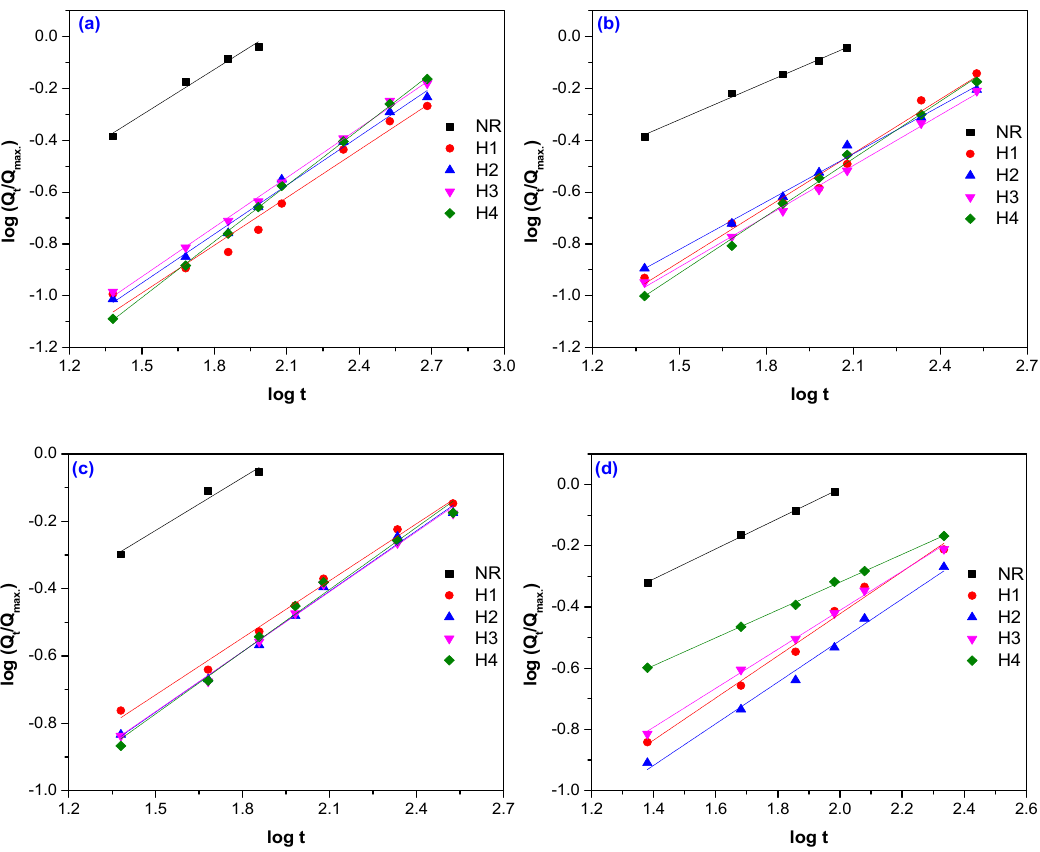
Figure 5. Determination of the diffusion parameters n and k for NR samples reinforced with hemp and vulcanized by electron beam (EB) irradiation at 75 kGy ( a ), 150 kGy ( b ), 300 kGy ( c ) , and 600 kGy ( d ).